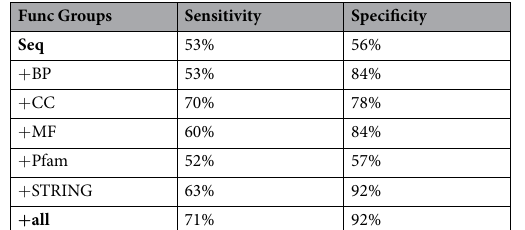
Table 2. Sn and Sp of prediction with sequence and functions (SVM).